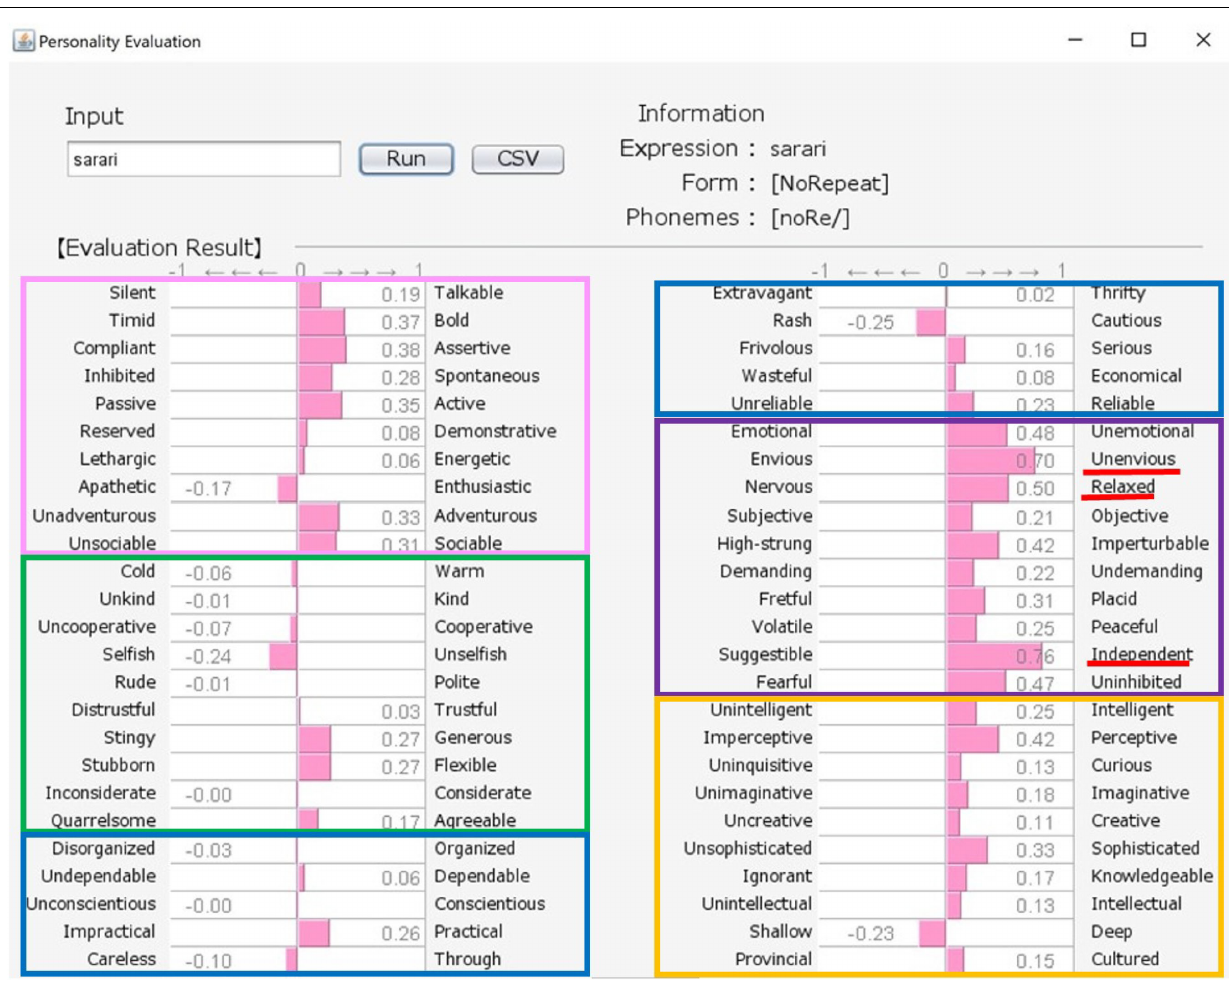
Frontiers in Psychology |